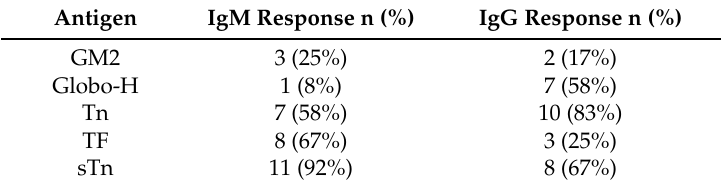
Figure 2. Anti-sTn (IgG and IgM) antibody titers of patients vaccinated with the unimolecular pentavalent-KLH vaccine.